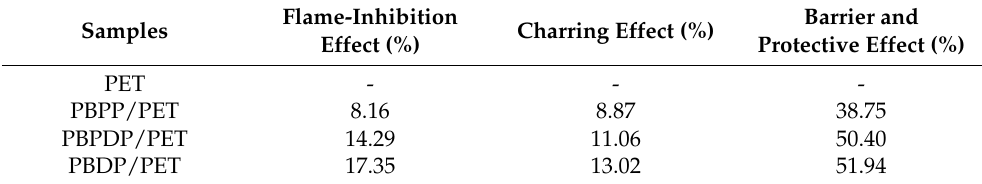
Table 3. Calculation results of three main flame-retardant